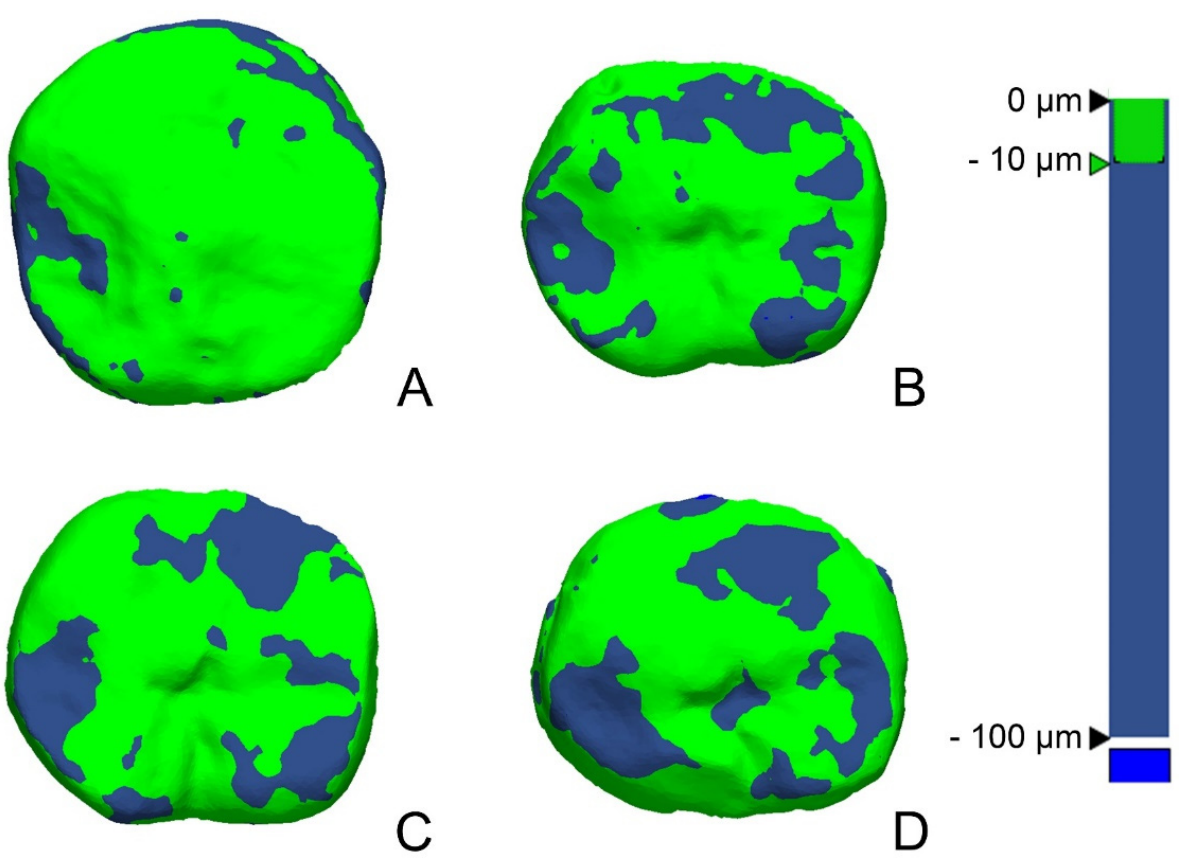
Figure 5. Comparison of 3D wear according to build angle. ( A ) Conventional method. ( B ) 3D-printing build angle of 0 degree. ( C ) 3D-printing build angle of 45 degrees. ( D ) 3D-printing build angle of 90 degrees.